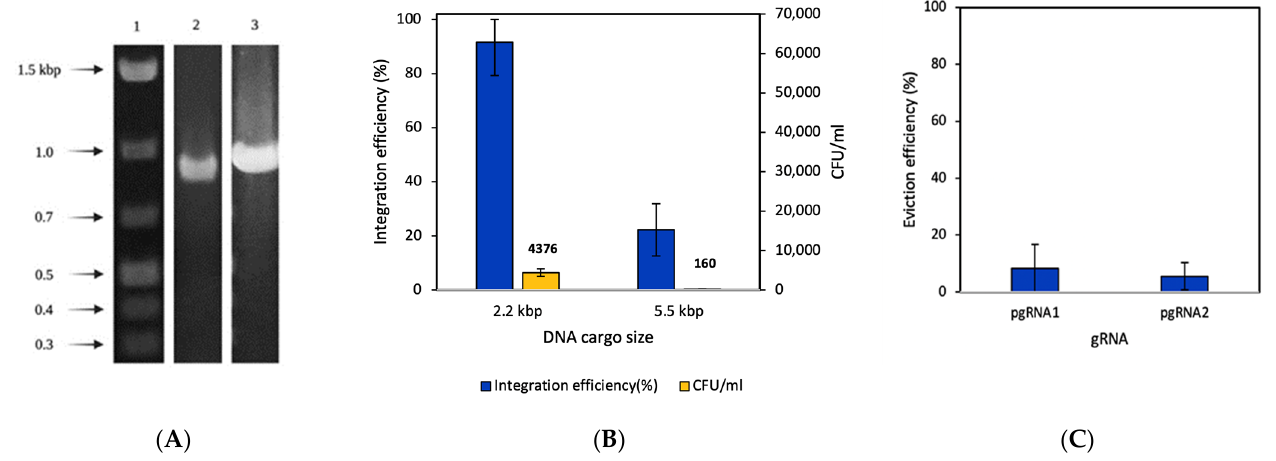
Figure 3. ( A ) Colony PCR screening of cas9 and bktB : phaB integrations via λ Red recombineering (column 2–3). To screen for cas9 integration, primers P069/P070 amplified an 858 bp fragment (column 2). To screen for bktB : phaB integration, primers P071/P072 amplified a 930 bp fragment (column 3). ( B ) Integration efficiency based on colony PCR (ratio of colonies containing the desired mutation to the total number of colonies screened for colony PCR) and colony count (CFU/mL) of each transformation employing λ Red recombineering system to integrate small- and large-size DNA cargos. ( C ) pgRNA plasmid eviction efficiencies confirmed by spectinomycin sensitivity (ratio of colonies with successful plasmid eviction to total number of colonies screened for antibiotic sensitivity). All values are reported as means ± SD ( n = 3).